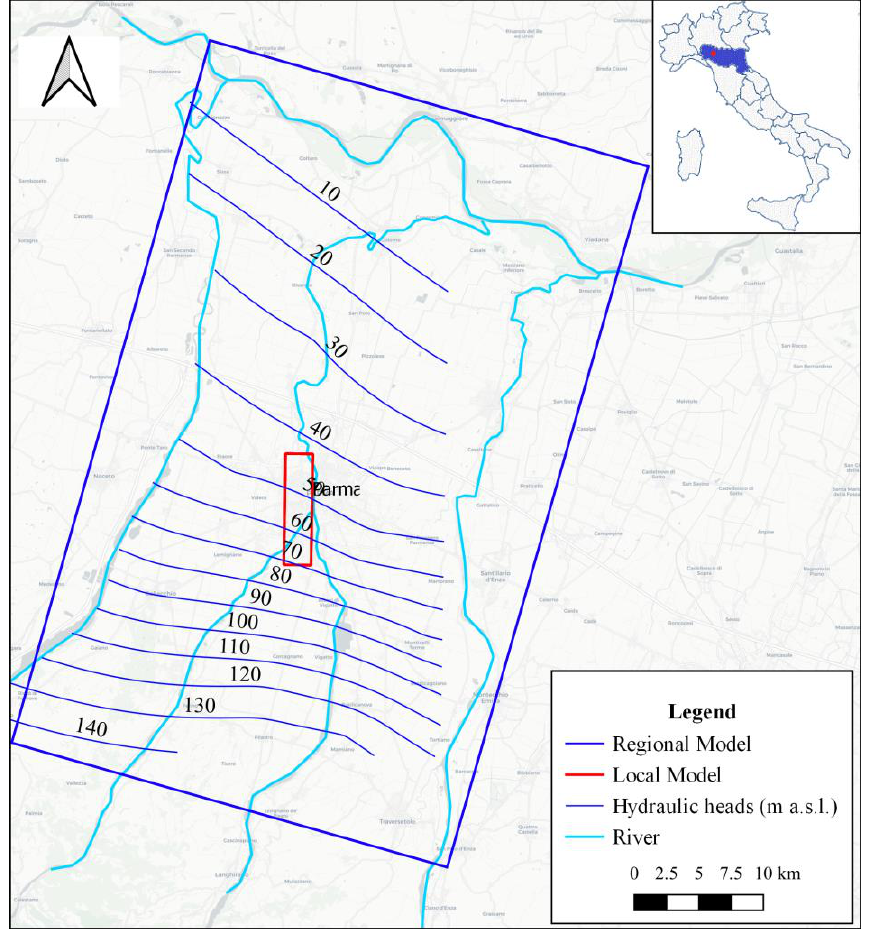
Figure 2. Study Area. Regional and local groundwater numerical model, hydraulic heads (autumn 2015) in m a.s.l.